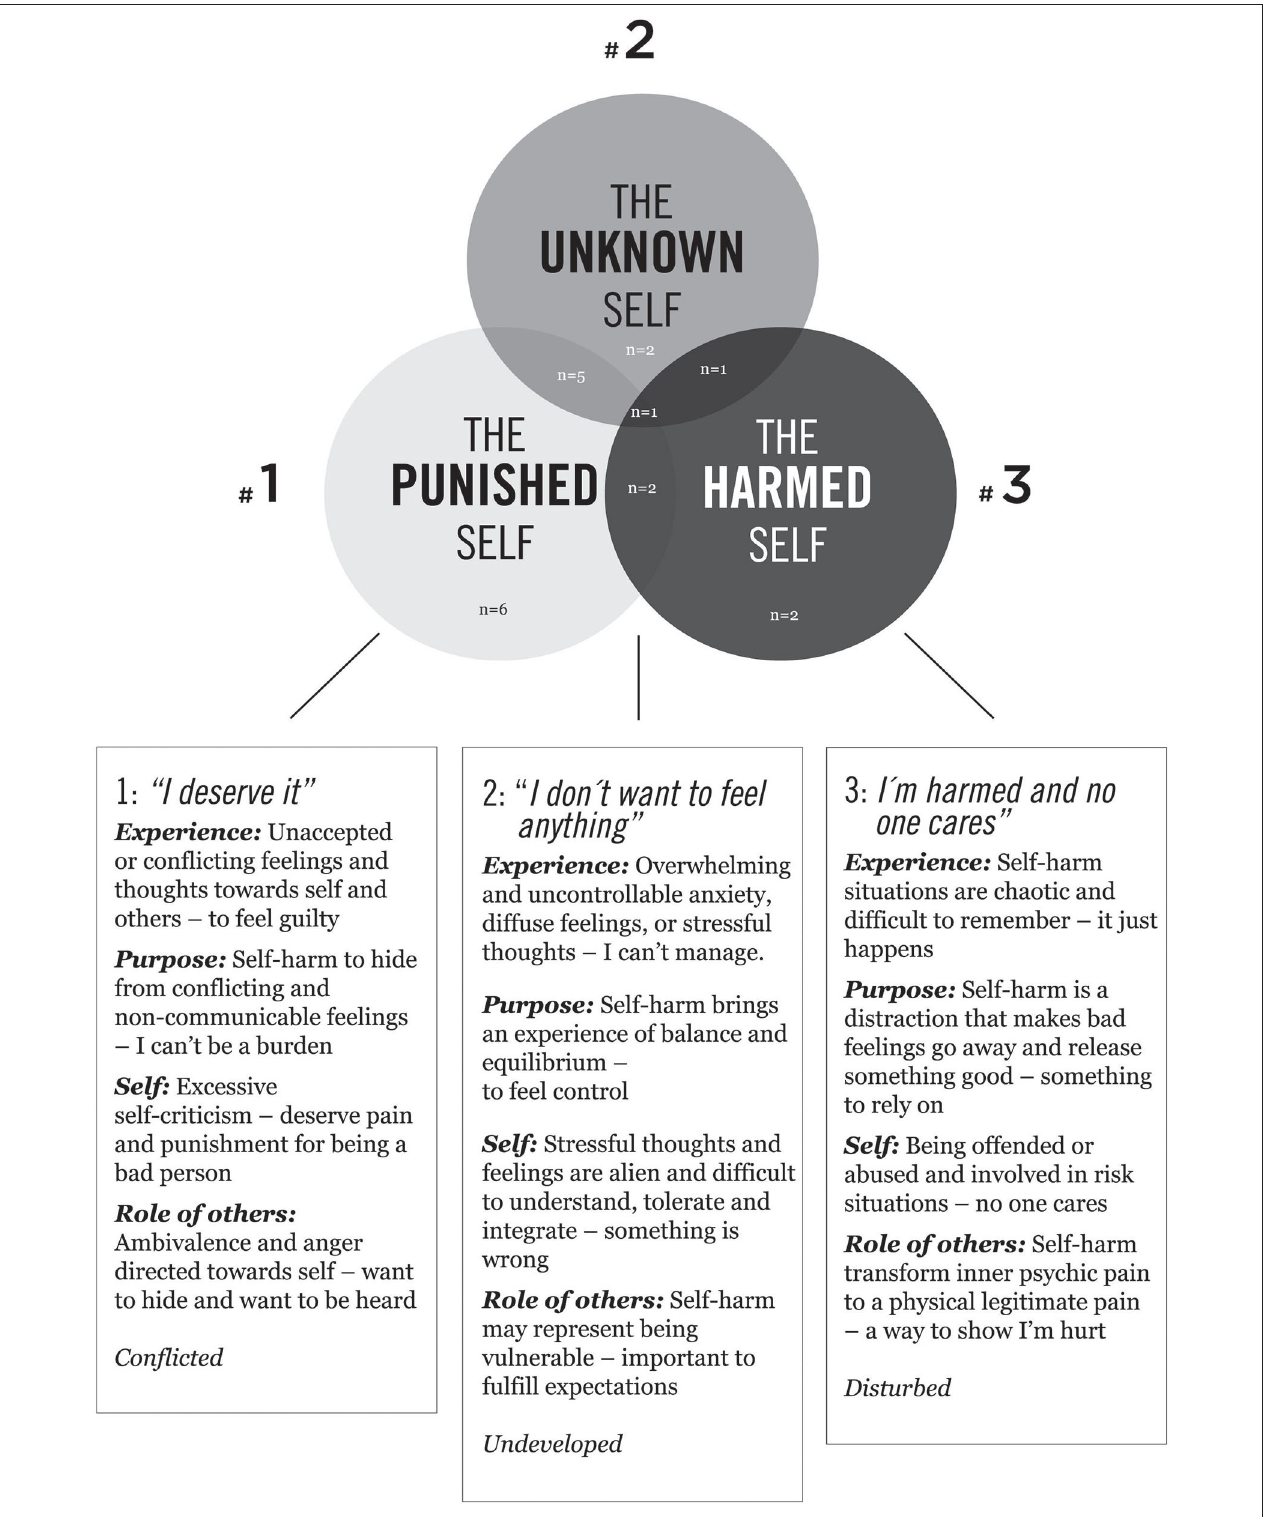
FIGURE 1 | Three superordinate themes and associated themes convey adolescents’ lived experience of self-harming.